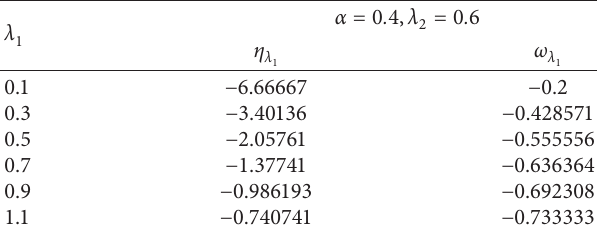
Figure 6: Sensitivity analysis on reliability function t ∈ [ 0 , 20 ] .